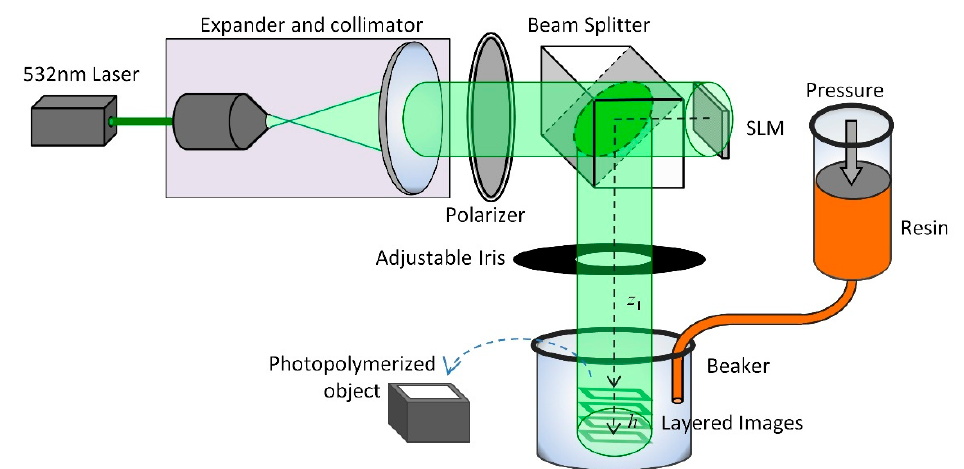
Figure 5. 3D printing apparatus based on holographic 3D display (3DHD).